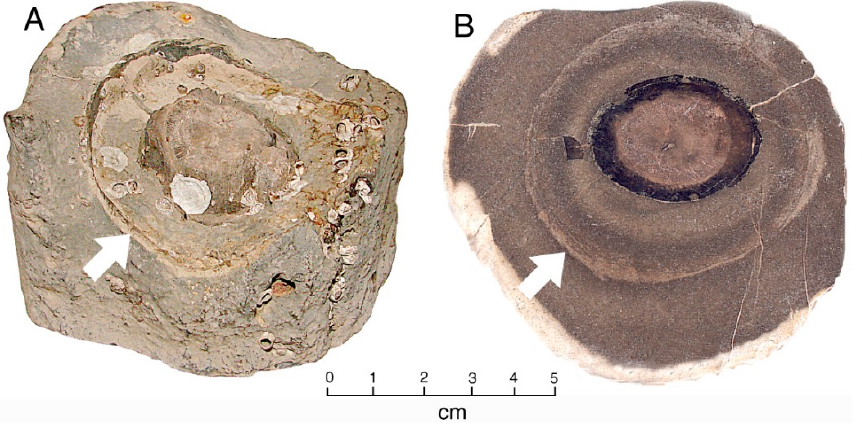
Figure 11. Transverse view of permineralized limb in calcareous concretion from intertidal zone at Collishaw Point, Hornby Island. ( A ) Exterior view of weathered concretion, showing whitish scars left by attached barnacles. ( B ) Polished sawn surface. Arrows mark the outer boundary of the concentric zone of calcification. The outer surfaces of the concretion are the boundary limit for the pervasive phase of cementation. Note that the concentric zone is partially bleached near the fossil wood. The darkest layer is carbon-rich bark.